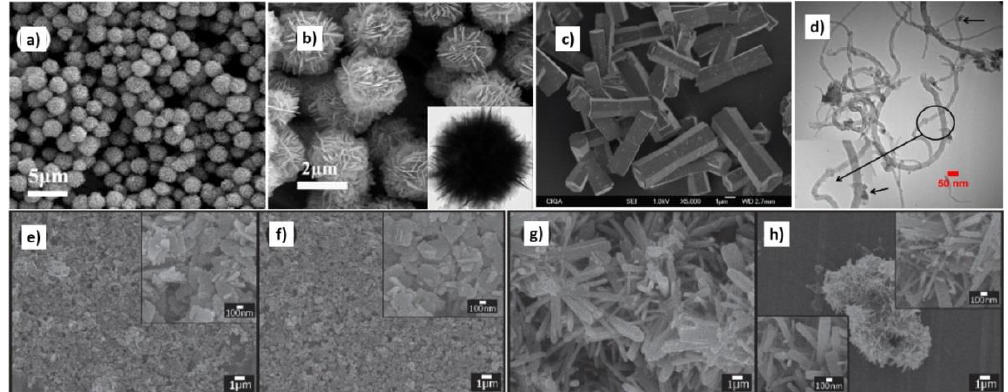
Figure 19. Examples of various ZnO structures obtained by the microwave hydrothermal synthesis: